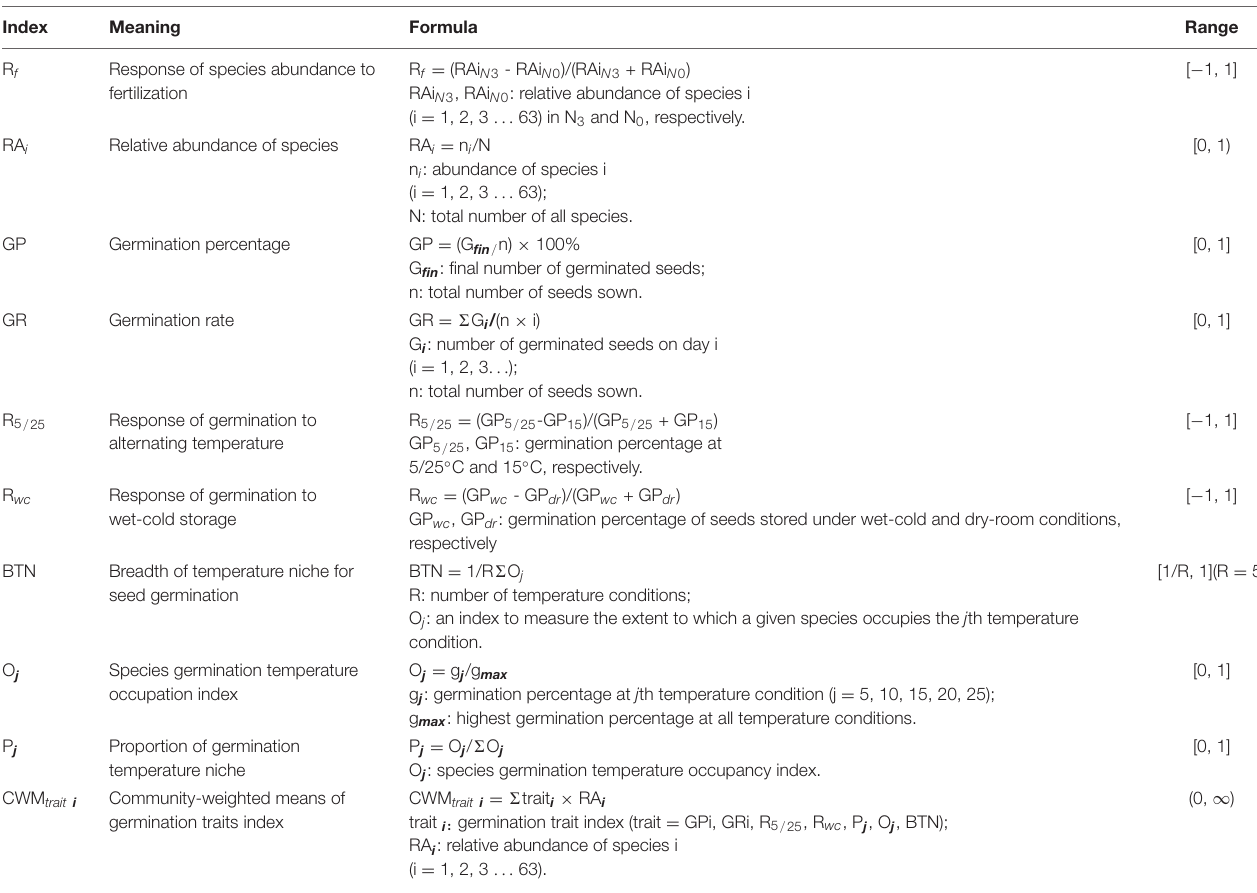
TABLE 1 | Indices used in this